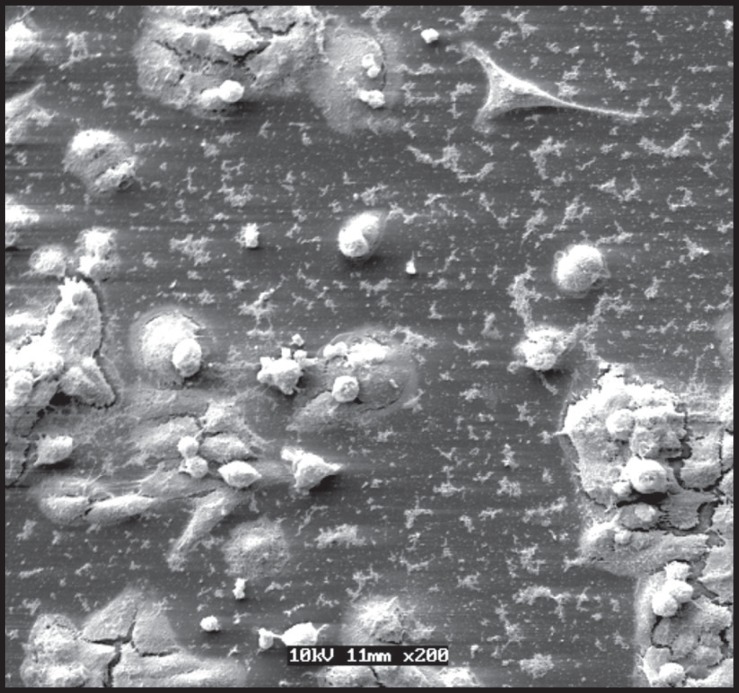
1 % chlorexidine - 60 s +24-h recovery: Note the smaller number of remaining
cells and rests of cytoplasmatic processes that detached from the substrate
(Scanning Electron Microscopy original magnification ×200)